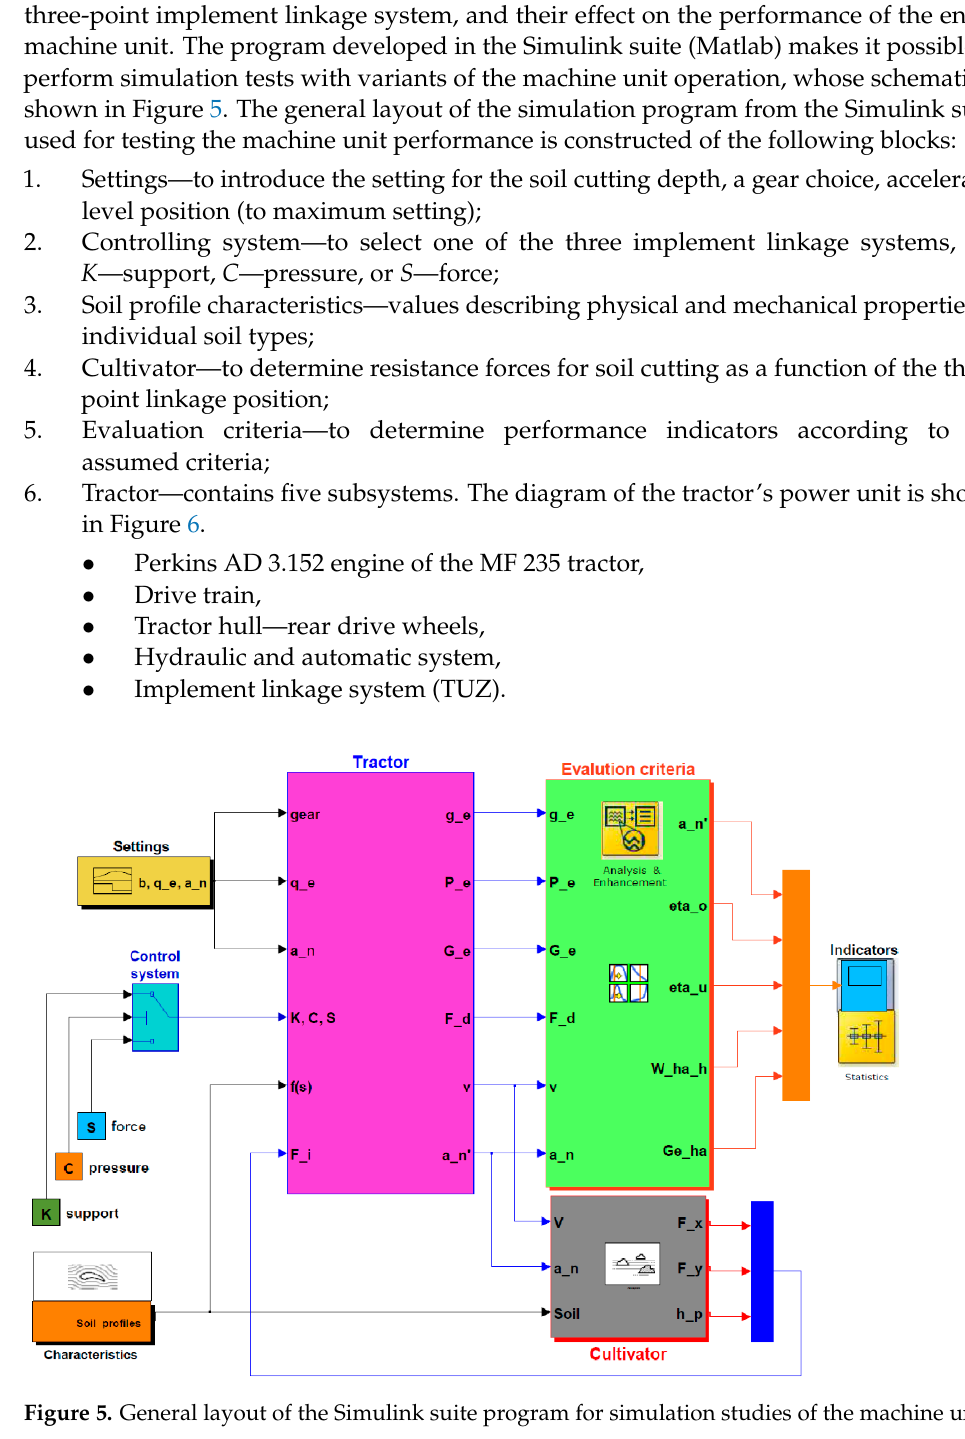
Figure 6. Scheme of the tractor subsystem in the Simulink suite program for simulation studies of the machine unit. The operation of the tractor engine, in terms of its loads and speed, generates torque and fuel flow data, from which this performance map is drawn [26]. On the basis of ex- perimental studies, the characteristics of the tractor’s diesel engine operation in the entire range of its full load and speed as well as specific fuel consumption were developed. In the engine subsystem (Engine Perkins AD 3.152, tractor MF 235) of the Simulink suite